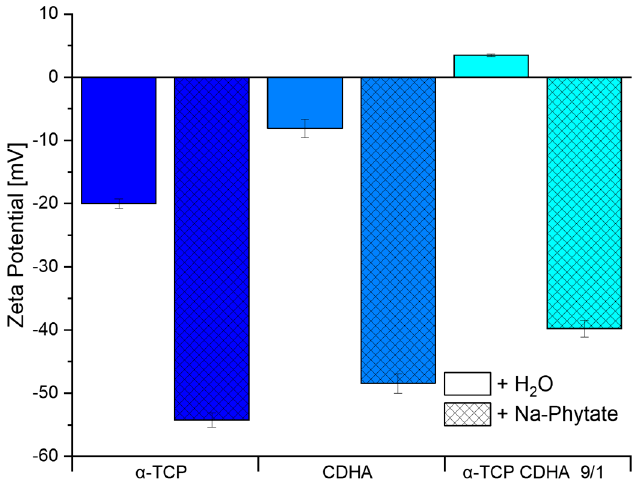
Figure 2. Surface charge of α -TCP, CDHA and a α -TCP / CDHA mixture in water and a 0.002 M sodium phytate solution determined by the zeta potential measurement. Every powder was prepared independently three times, and the error bars represent the standard deviation.